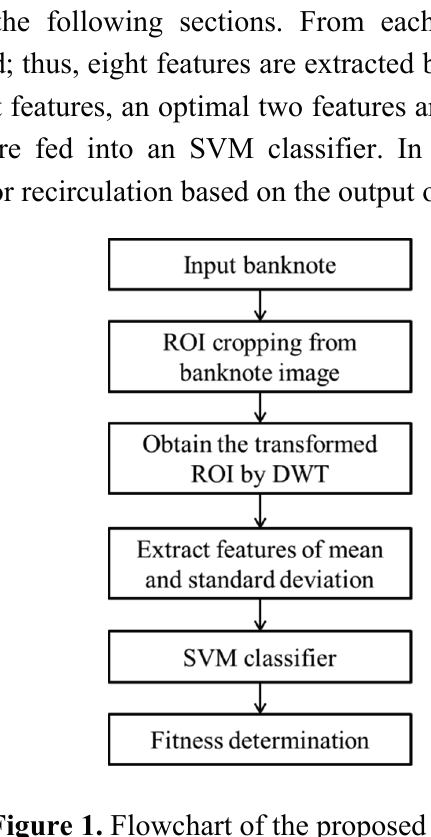
Figure 1. Flowchart of the proposed